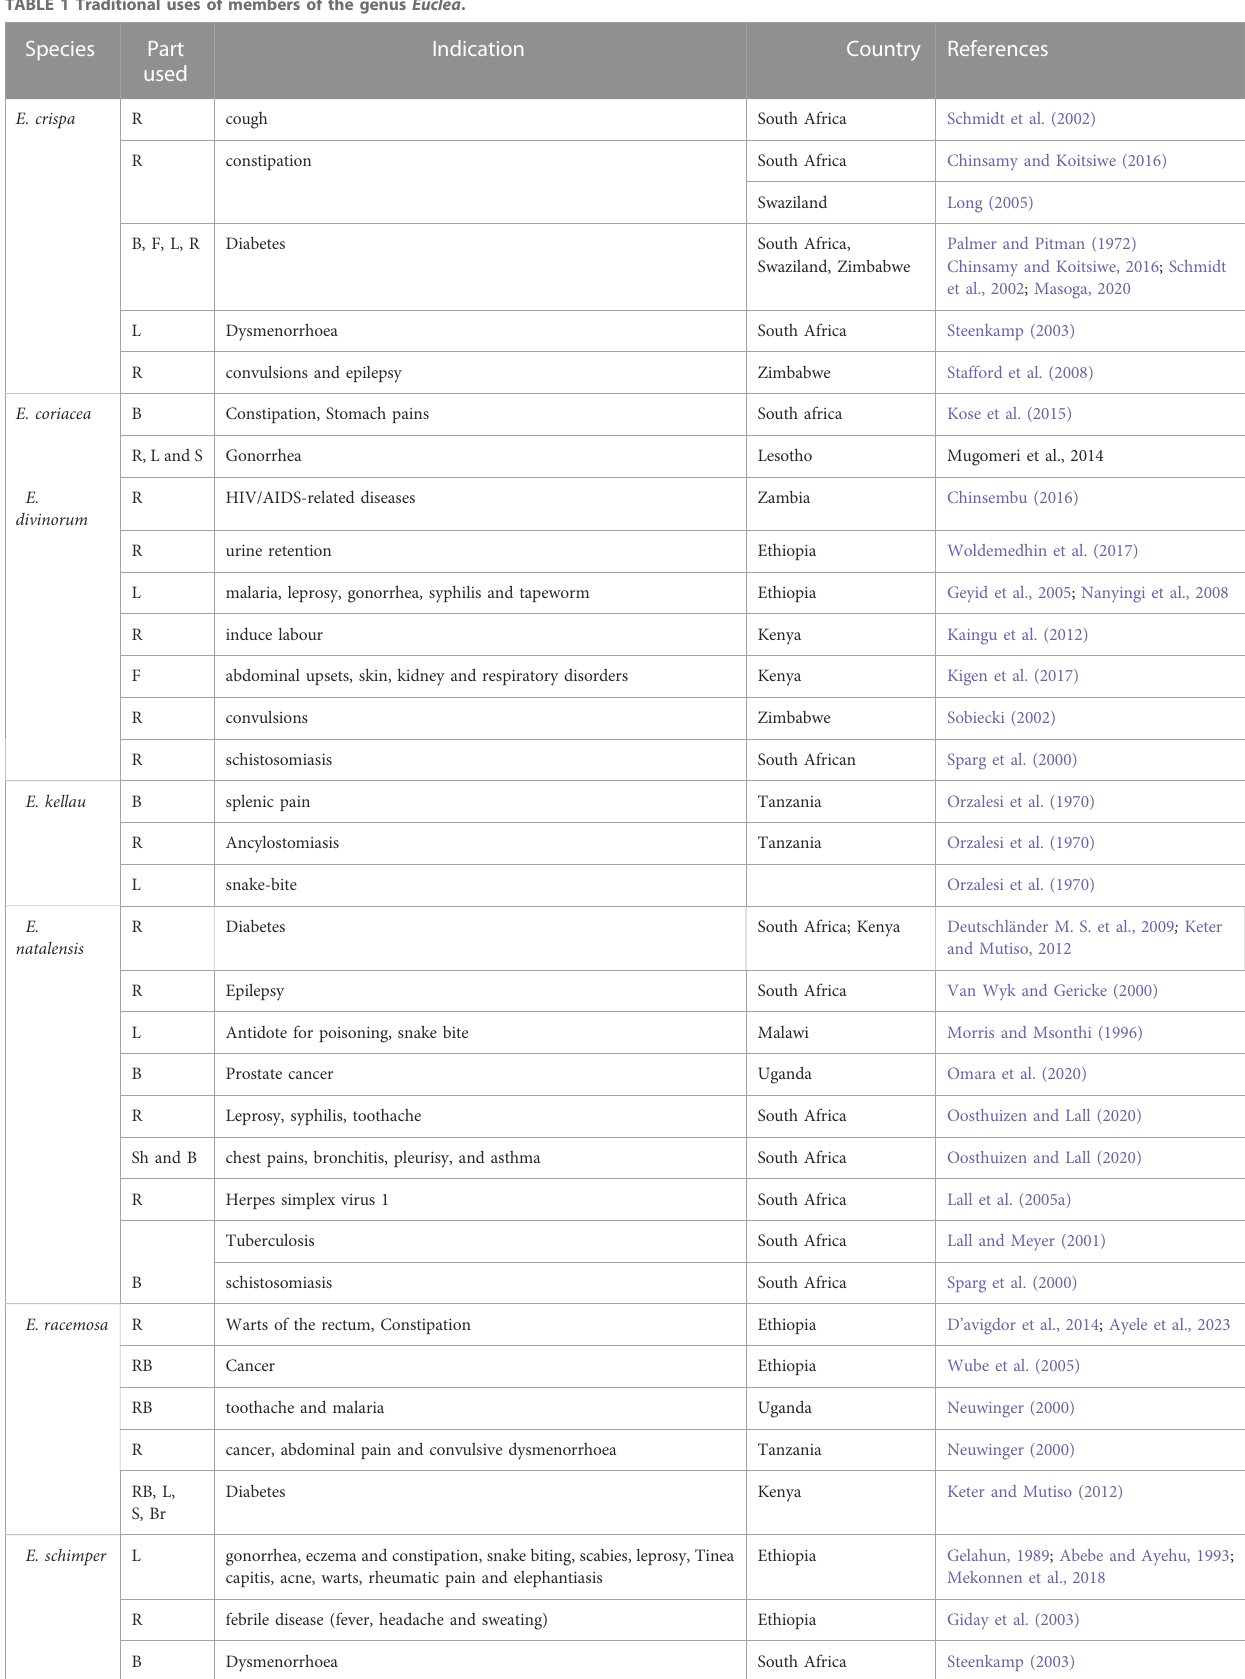
TABLE 1 Traditional uses of members of the genus Euclea . Species Part